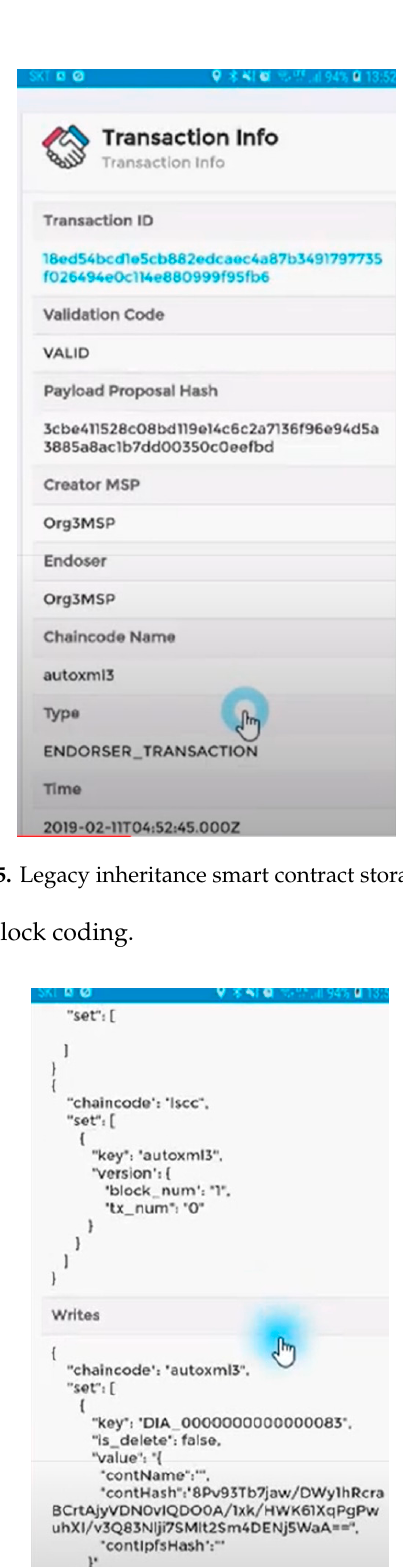
Figure 14. Legacy inheritance smart contract screen.